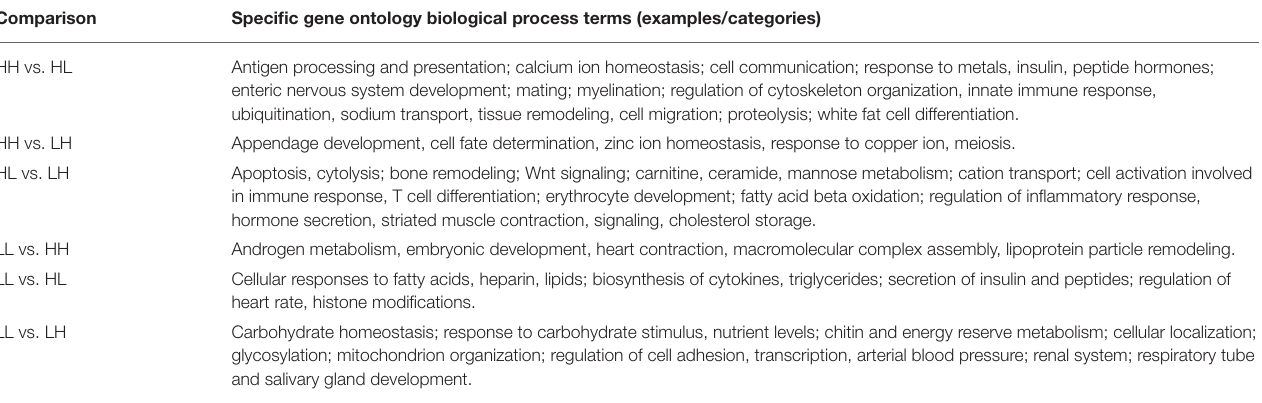
TABLE 3 | Summary of biological processes enriched for each statistical comparison in a specific fashion.